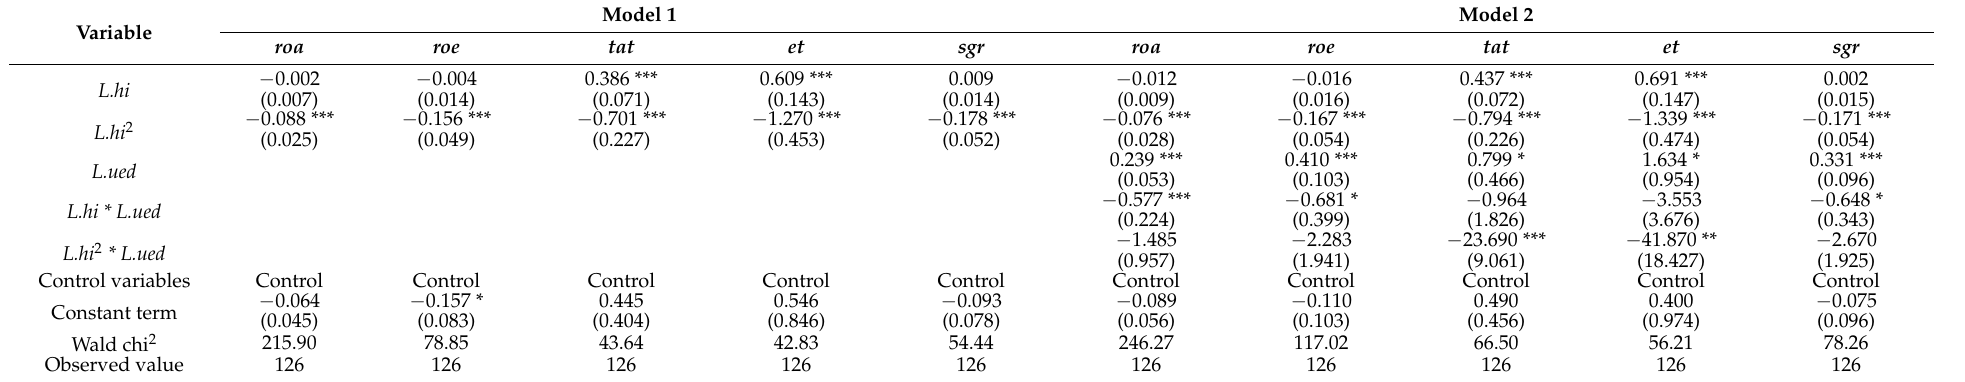
Table A2. Robustness test